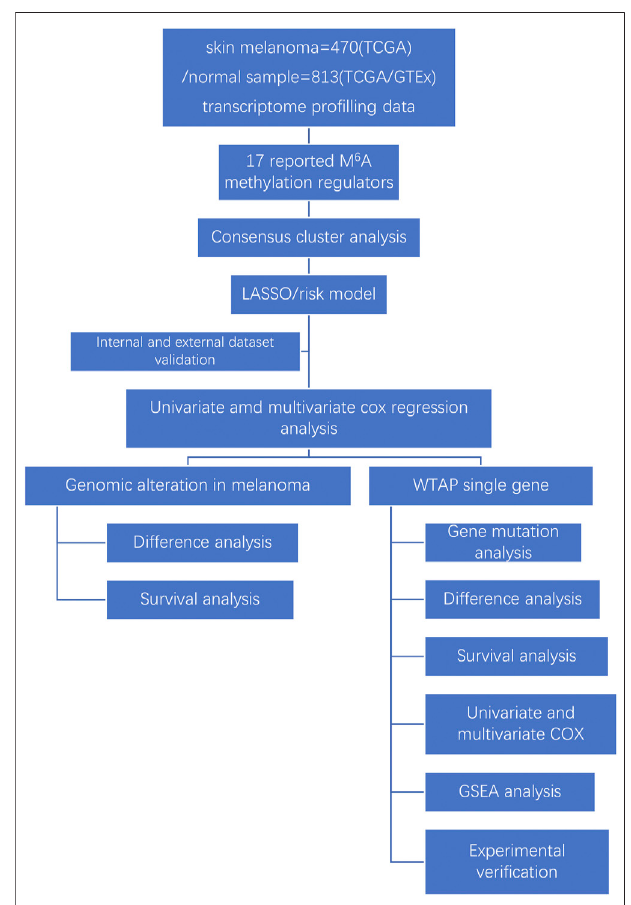
FIGURE 1 | Work fl ow chart of data generation and